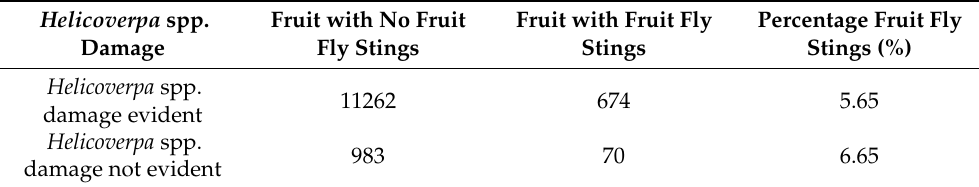
Table 4. The total number of fruit with and without fruit fly stings with recorded Helicoverpa spp. damage across Warroo and Traprock orchards.